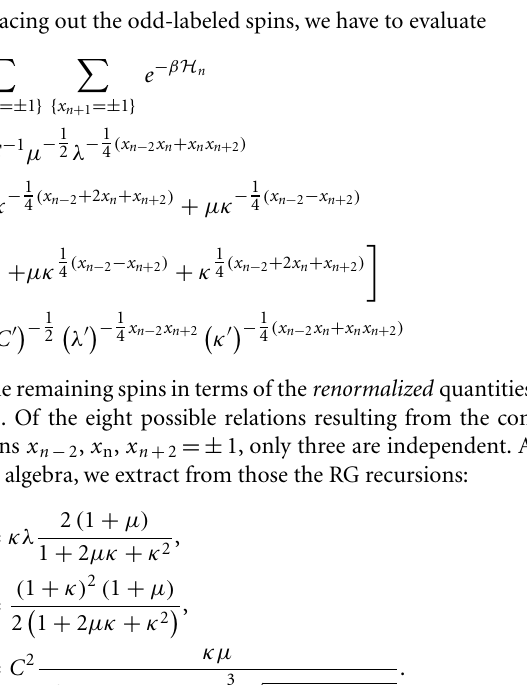
) on the bottom in 0